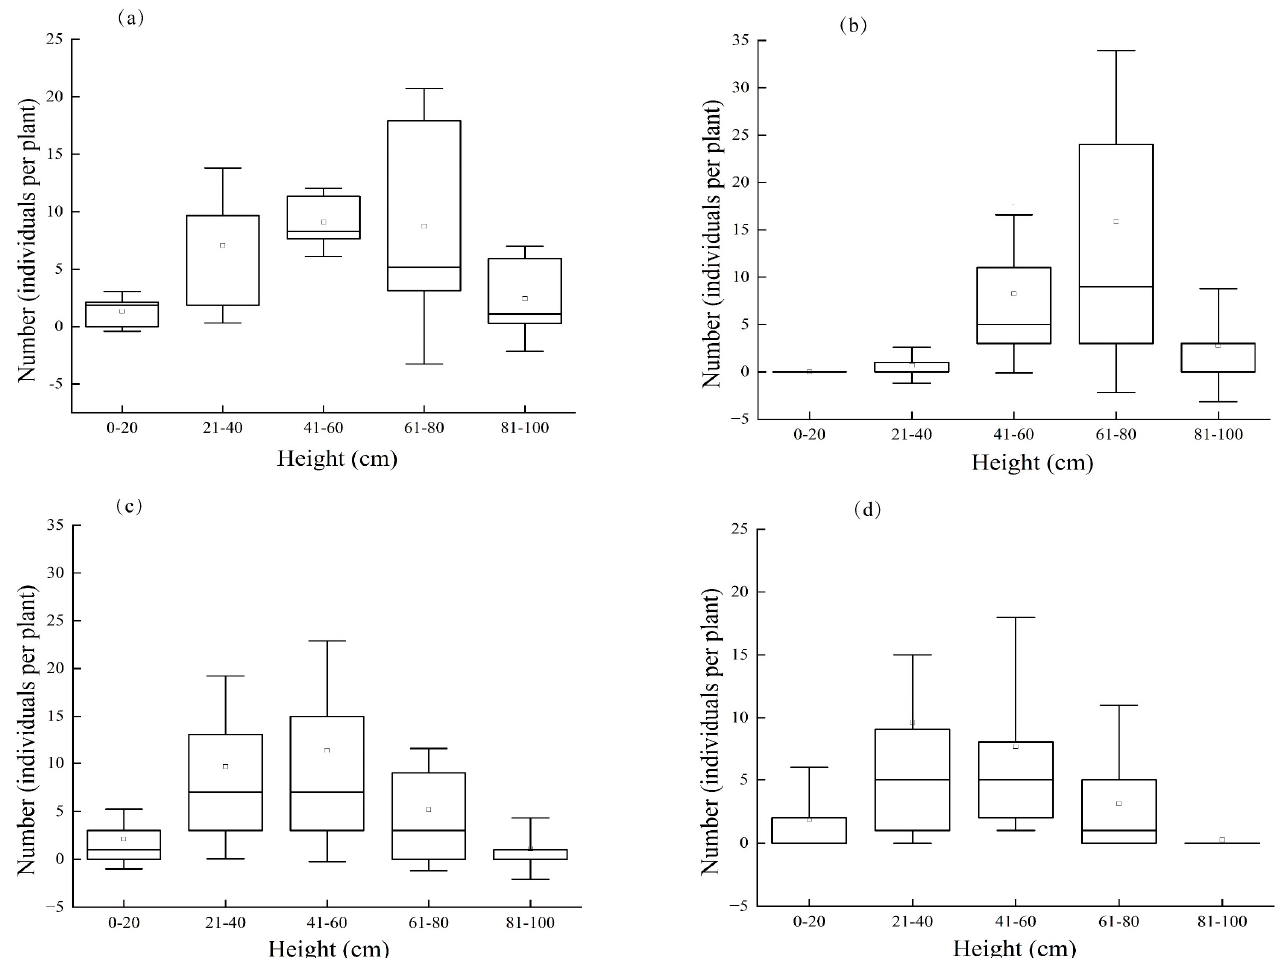
Figure 4. Vertical distribution of C. aeruginosa in different larvae instars. (( a ) Vertical distribution of the mean number of larvae; ( b ) vertical distribution of first and second instar larvae; ( c ) vertical distribution of third instar larvae; ( d ) vertical distribution of fourth instar larvae). Horizontal lines represent median value; circles represent average values; boxes represent upper and lower quartiles; vertical bars represent standard deviations.